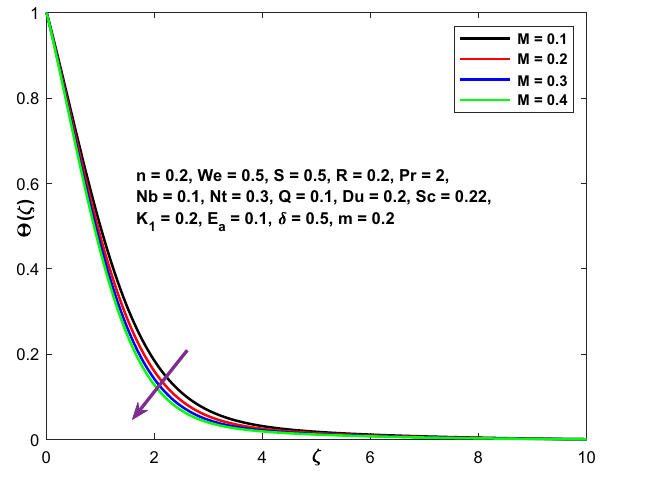
Figure 4. Character of M versus �(ζ) .